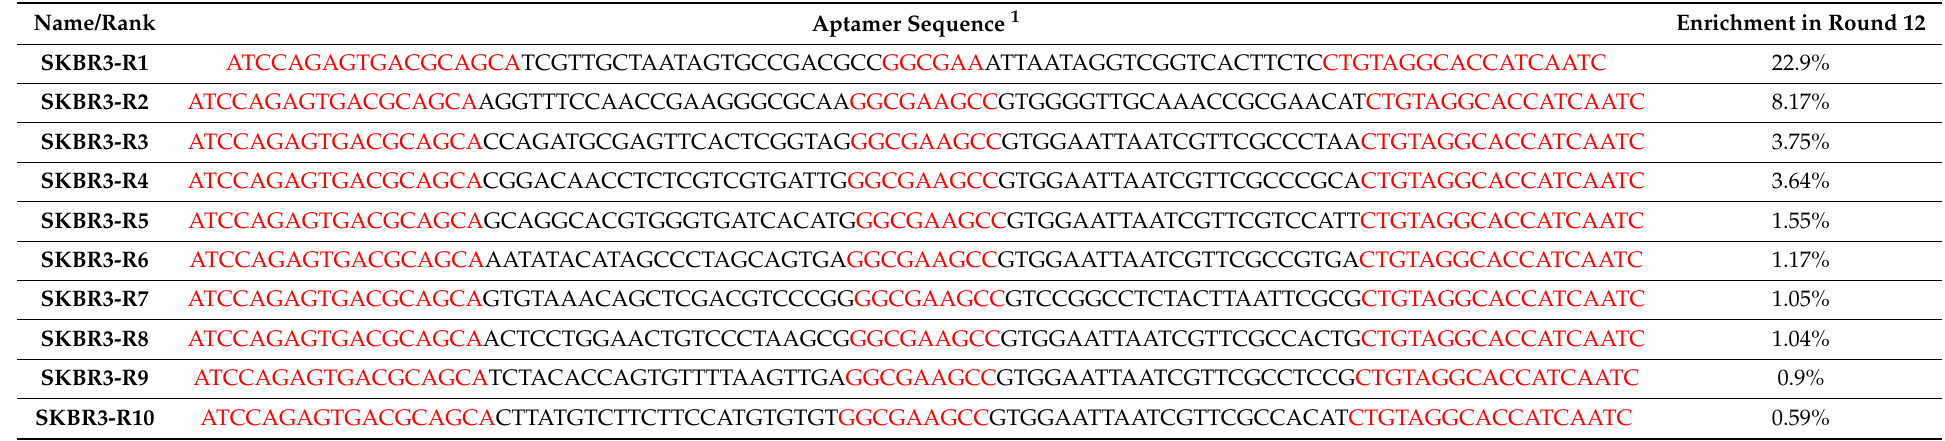
Table 1. Top 10 of raised aptamer sequences after 12 rounds of